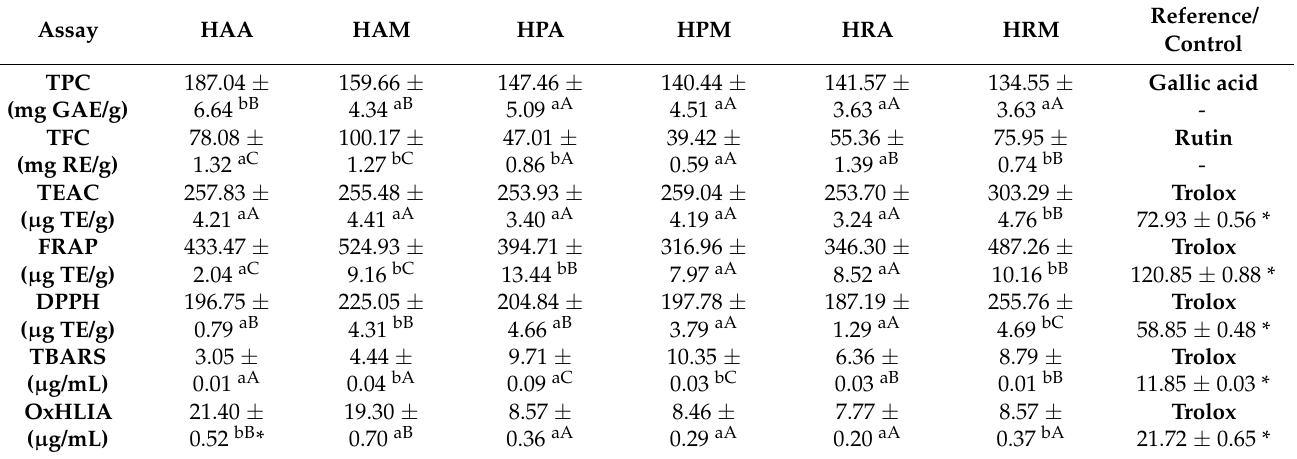
Table 2. Overview of TPC, TFC and antioxidant capacity values measured for Hypericum